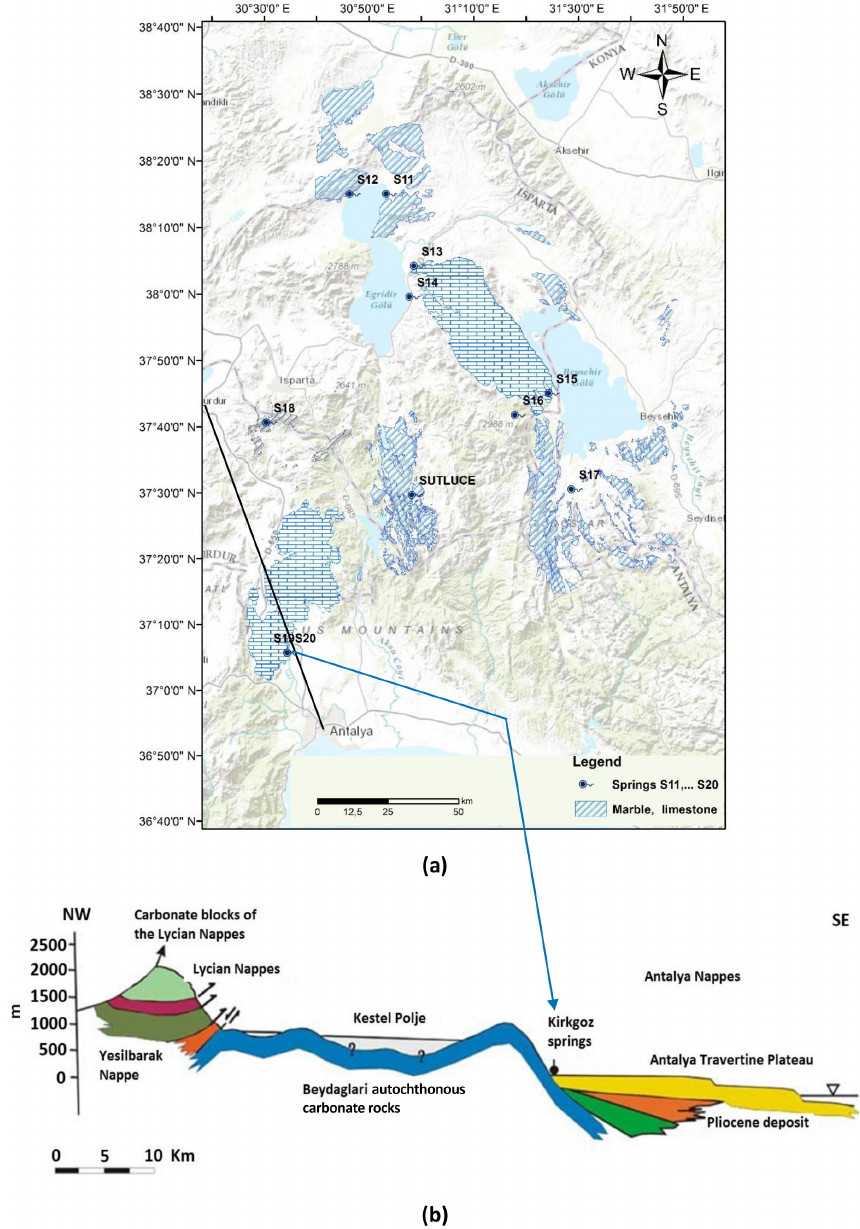
Figure 4. (a) Location map of Lake District marble and limestone, (b) the geological cross section of the Kirkgoz karst springs, southern Turkey (Ekmekçi,